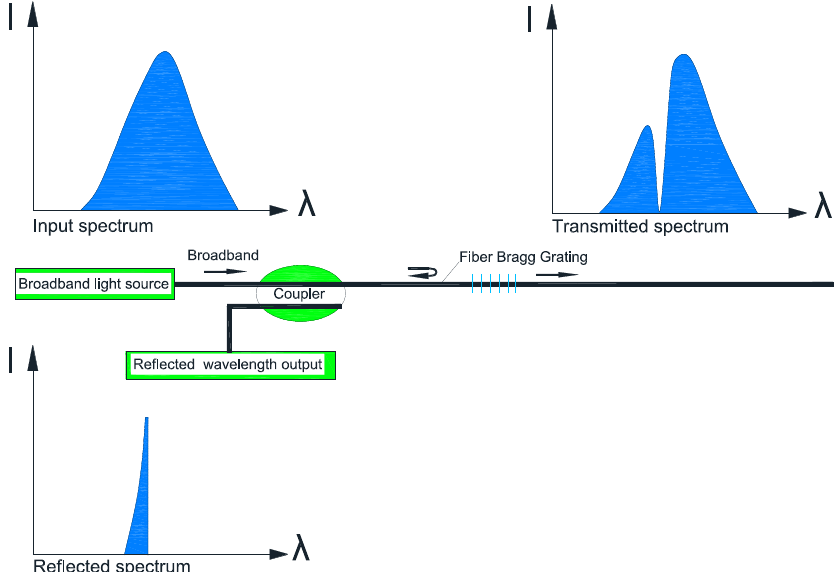
Figure 6. Functioning principle of the FBG sensor.